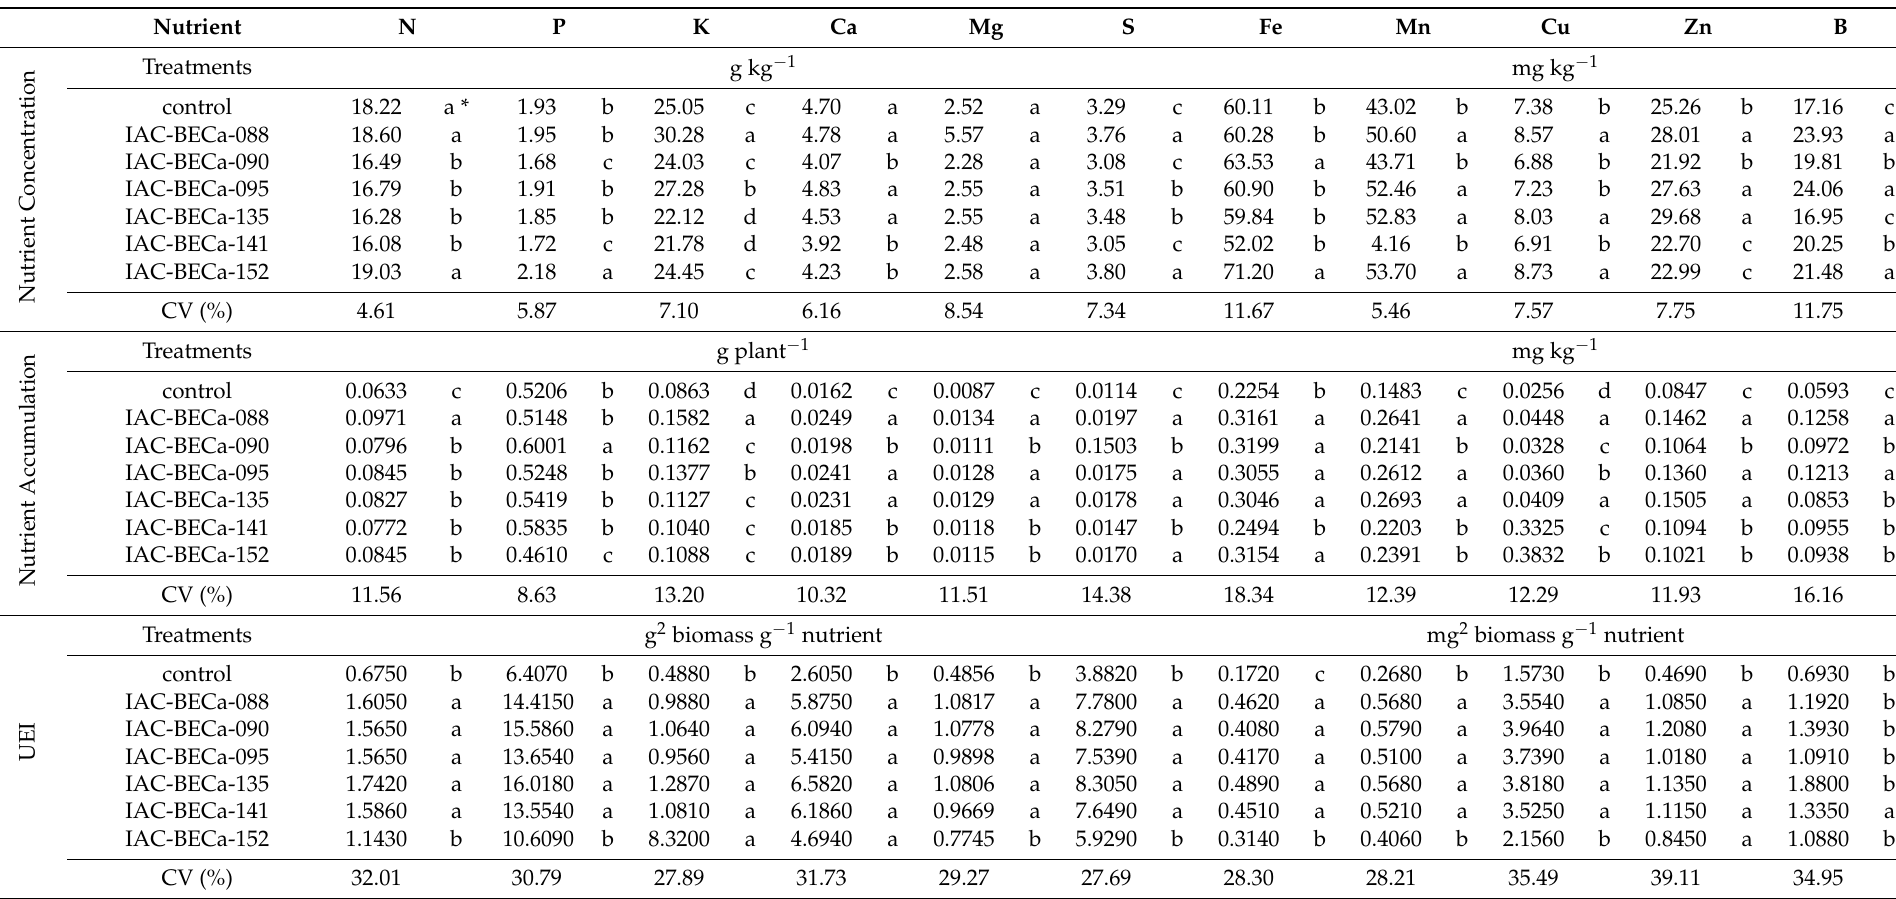
Table 4. Nutrient concentration, accumulation and nutrient-use efficiency index (UEI) of macro and micronutrients in plant shoot due to the bacterial treatments, 45 days after transplanting (T45) into the